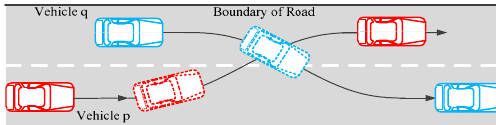
Figure 5. Typical lane changing scenario.